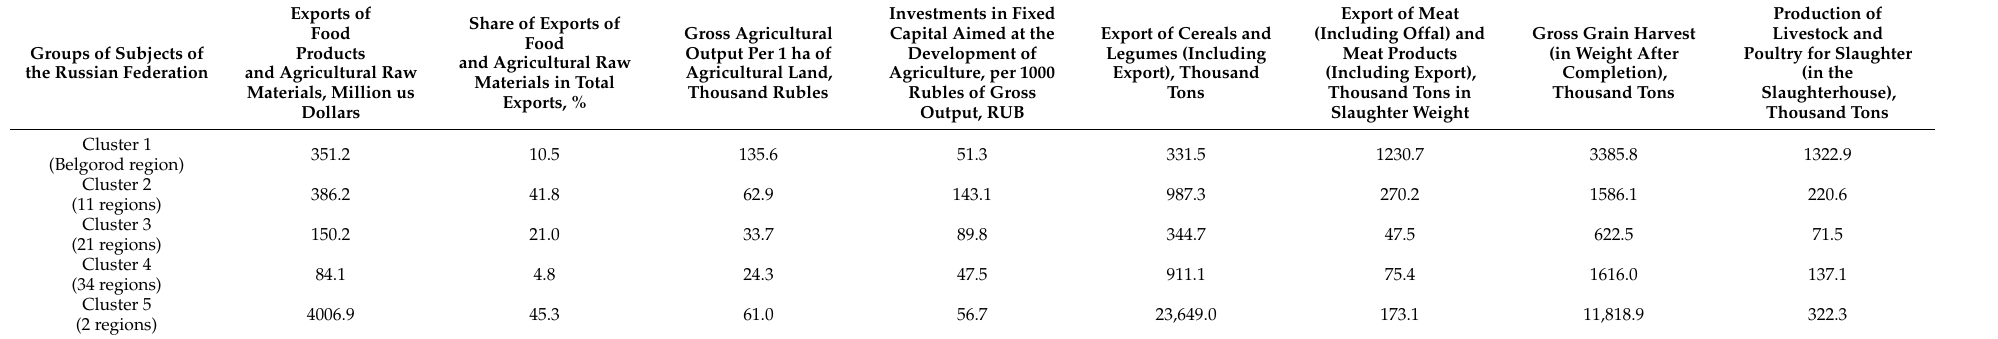
Table 4. Characteristics of clusters by level of production, investment and export